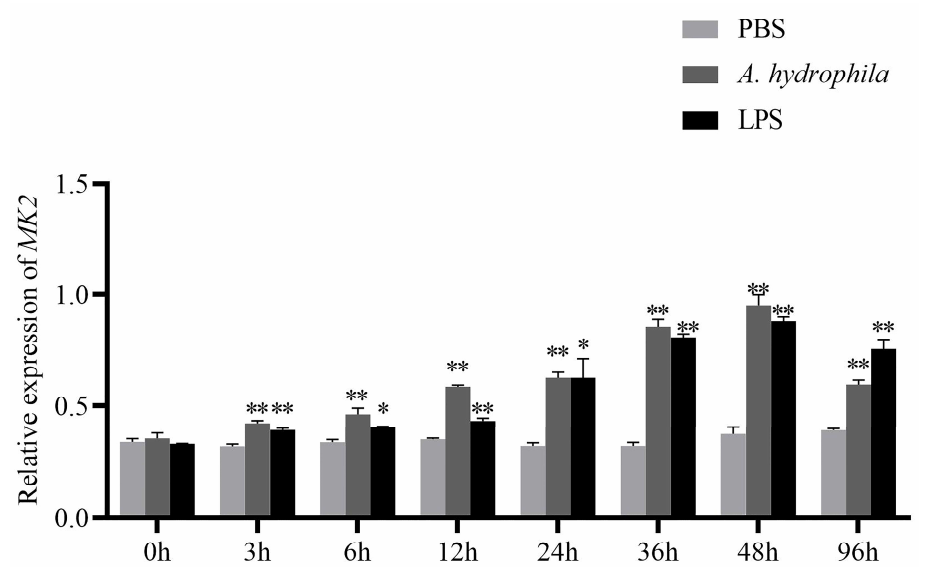
Figure 5. Relative expression of MK2 in the gills of H. cumingii after A. hydrophila and LPS infection. PBS buffer solution was injected into the control group. The horizontal axis was the time of immune response after injection. mRNA was collected at 0 h, 3 h, 6 h, 12 h, 24 h, 36 h, 48 h, and 96 h after A. hydrophila or LPS injection. The vertical axis was the relative expression of MK2 . The analysis of significance was marked with an asterisk. A single asterisk means there is a significant difference (* p < 0.05), and double asterisks mean a highly significant difference (** p < 0.01).